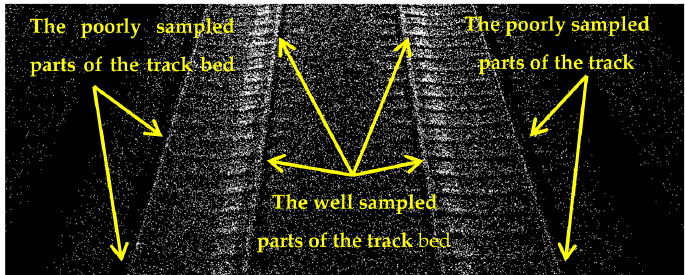
Figure 11. The non-uniform point sampling on the track bed. The point sampling around the inner rail tracks are much higher than that around the outer rail tracks. Table 1. Point Sampling on Various Parts of the Dataset.